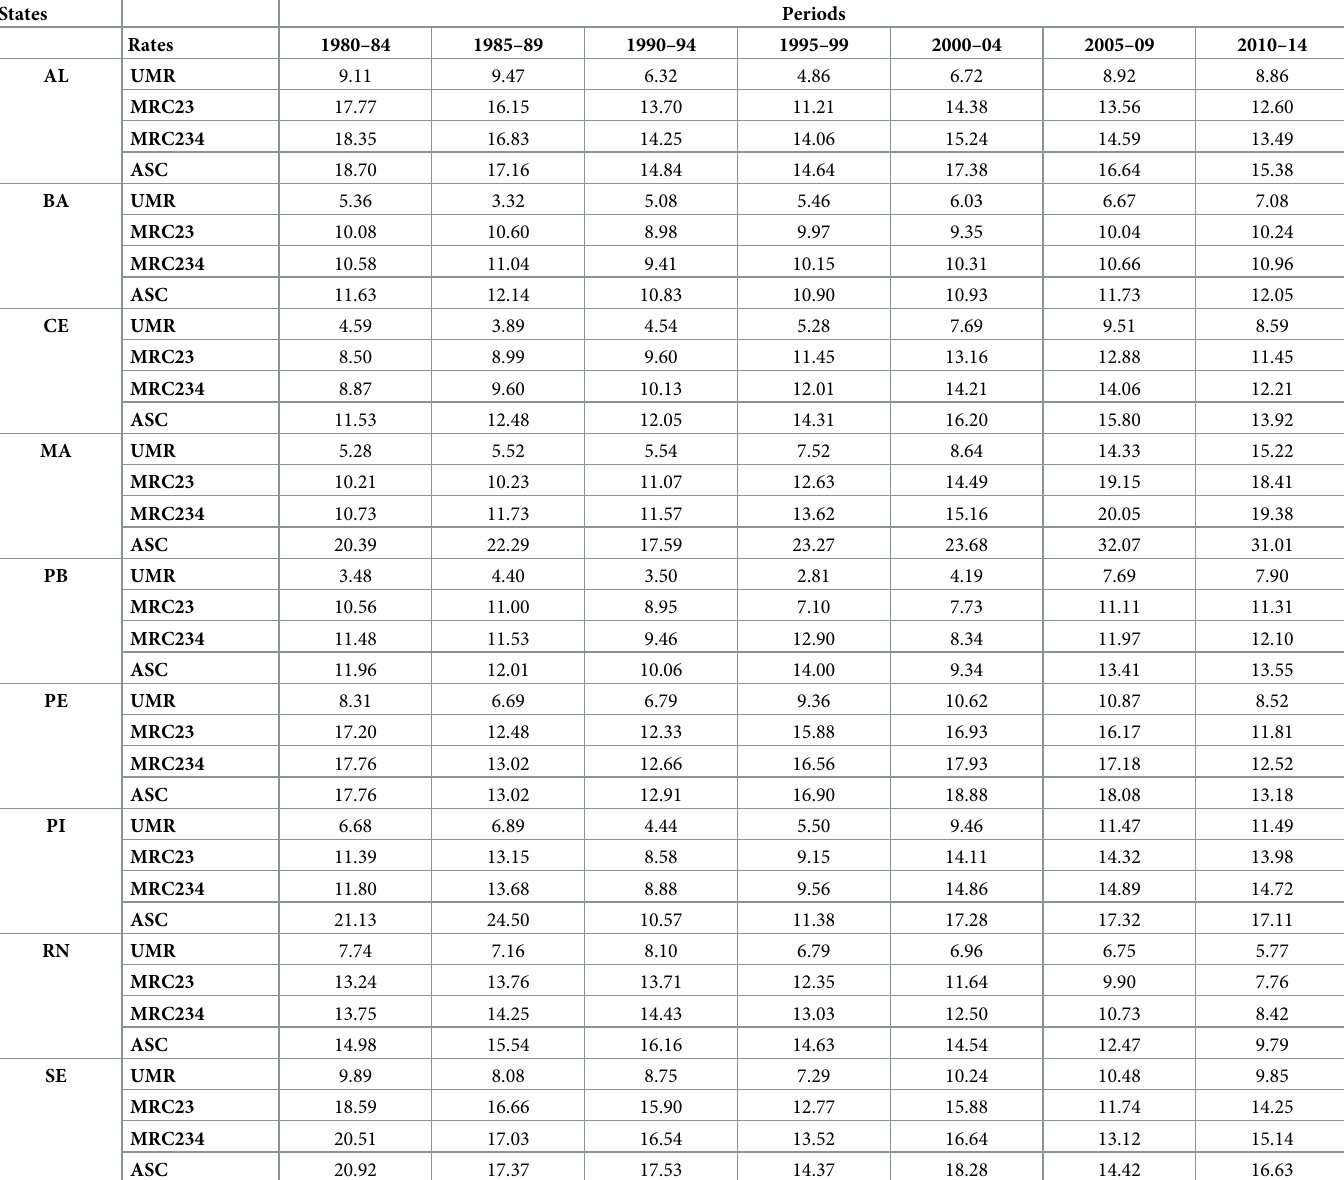
Table 1. Cervical Cancer mortality standardized rates (per 100,000 women) from 1980 to 2014 in the states of northeastern Brazil, according to the stages of the death registration correction process from 1980 to 2014. States